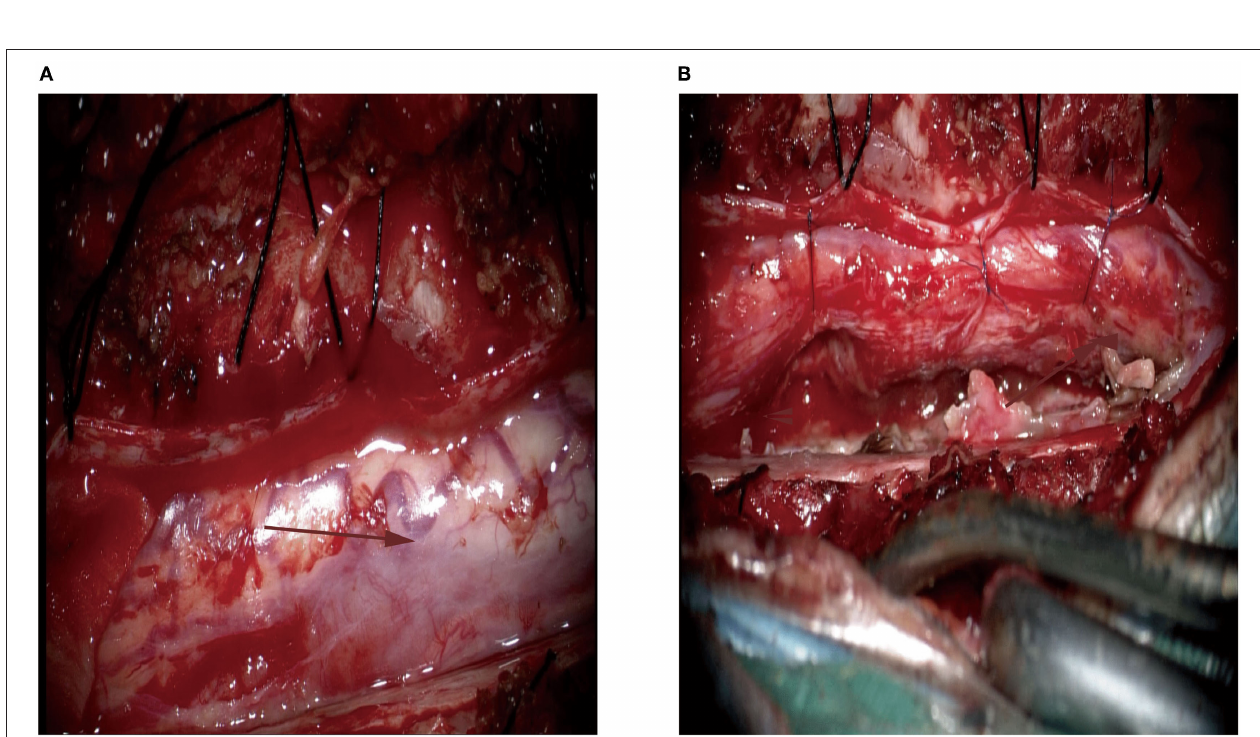
FIGURE 2 | Intra-operative image of the lesion located at the right ventral margin. (A) The lesion had abundant blood supply (the arrow); (B) The gross total resection was achieved. The Red arrow is mainly used to show the location of the